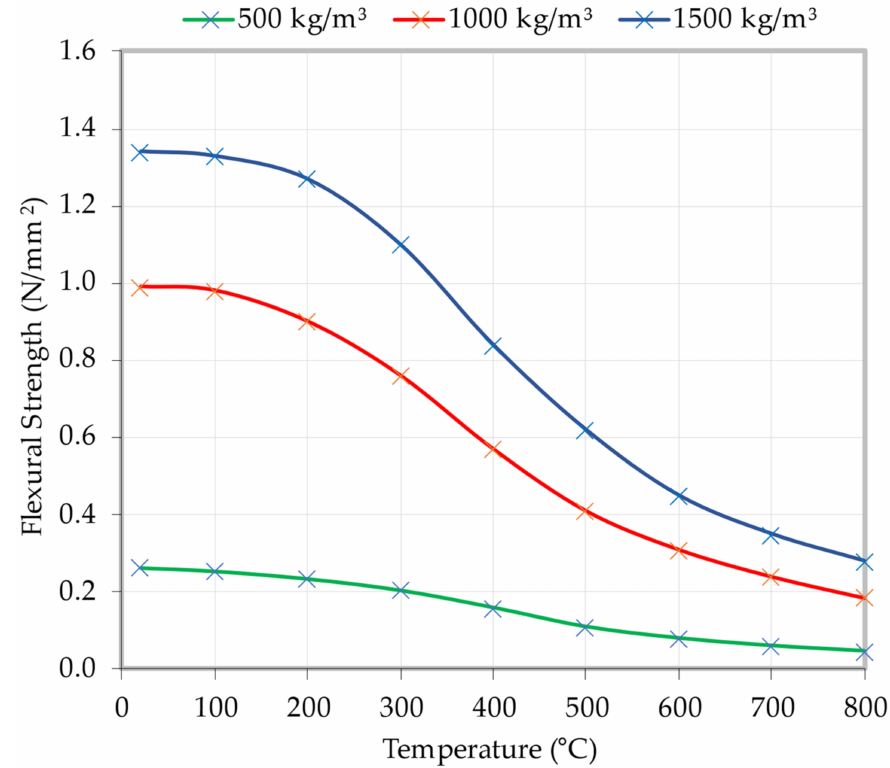
Figure 15. Influence of varying temperatures on the LFC flexural strength.